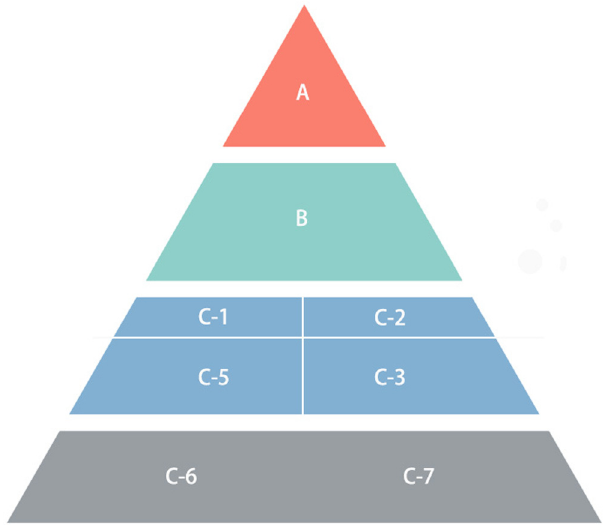
Figure 5: Final classi fi cation of burials in Taosi cemetery and possible implicated social